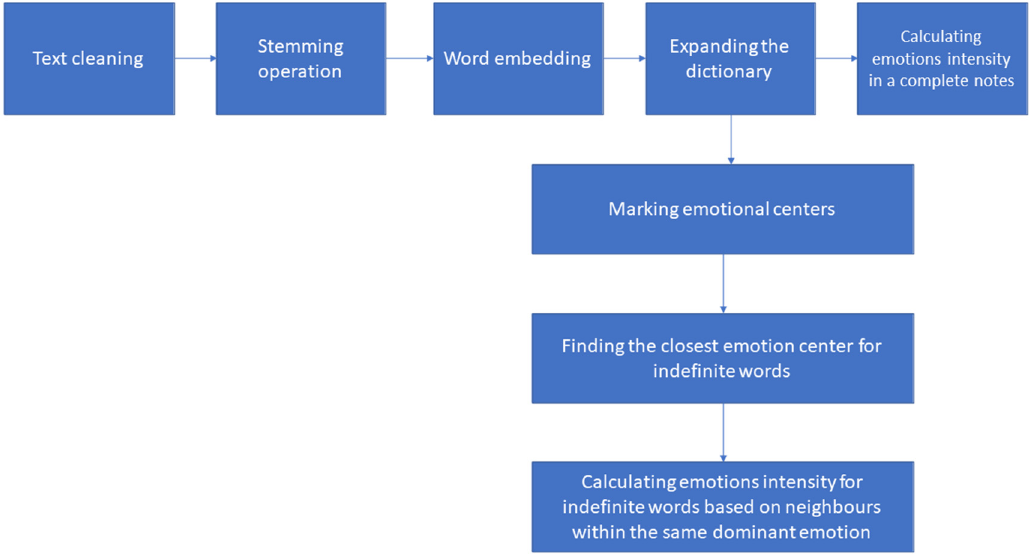
Figure 1. Method